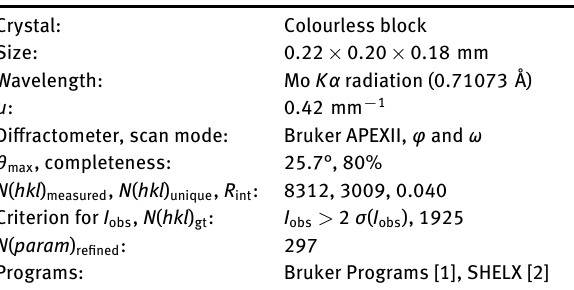
Table 1: Data collection and